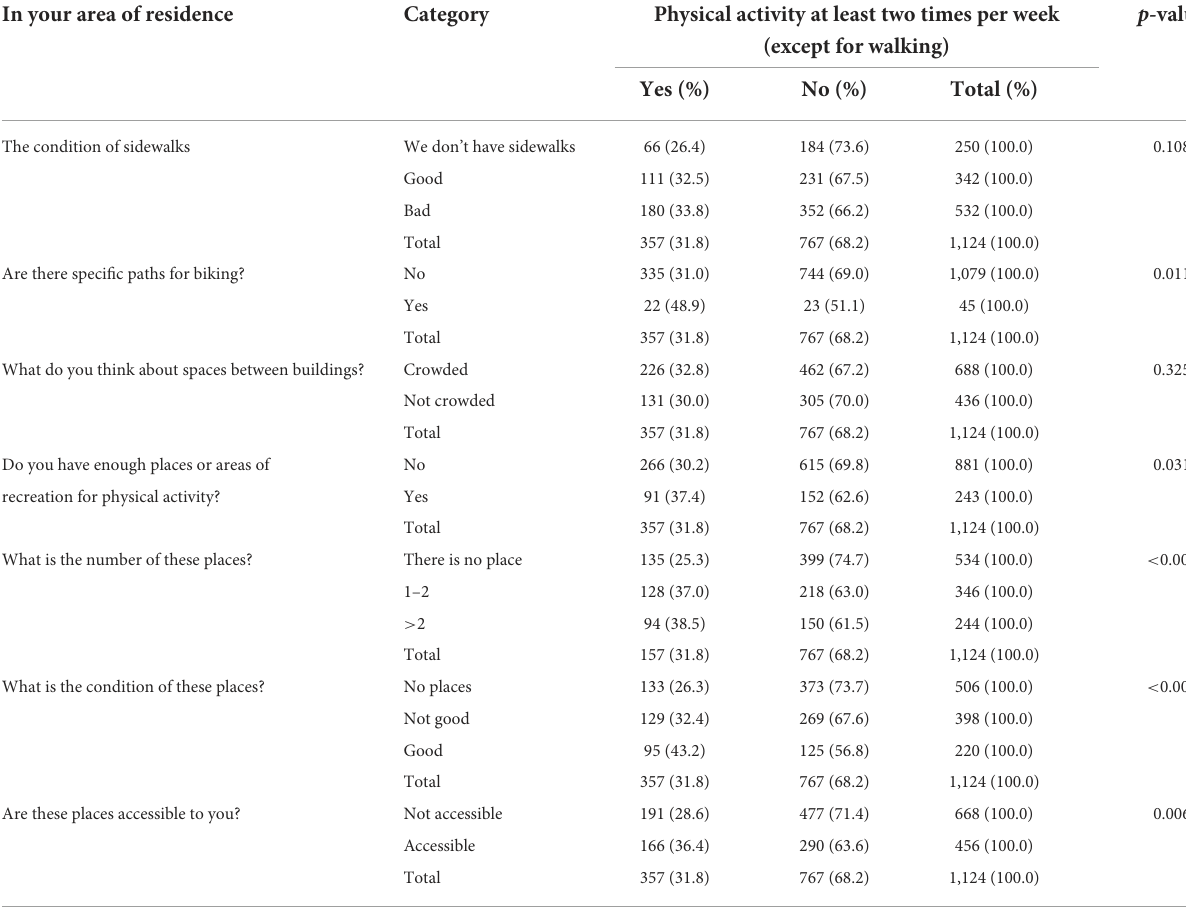
TABLE 4 Distribution of perceptions about built environment by physical activity at least 2 times per week of study participants ( N = 1,124). In your area of